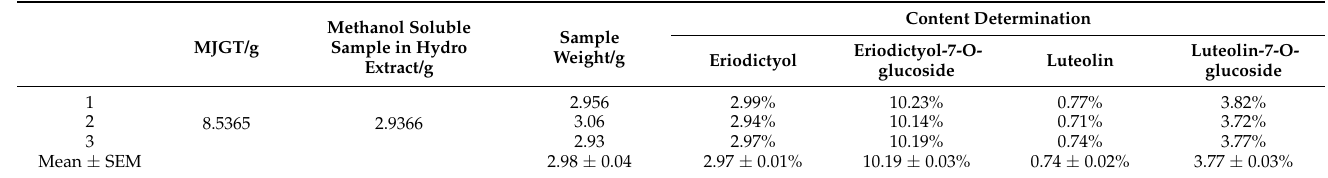
Table 1. Contents of flavonoids in methanol soluble sample of hydro extract of MJGT.